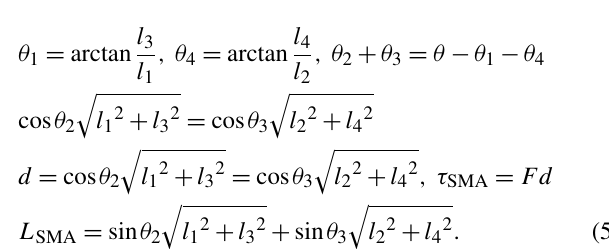
B 1 , respectively. l 1 and l 2 are the distances from C 1 and D